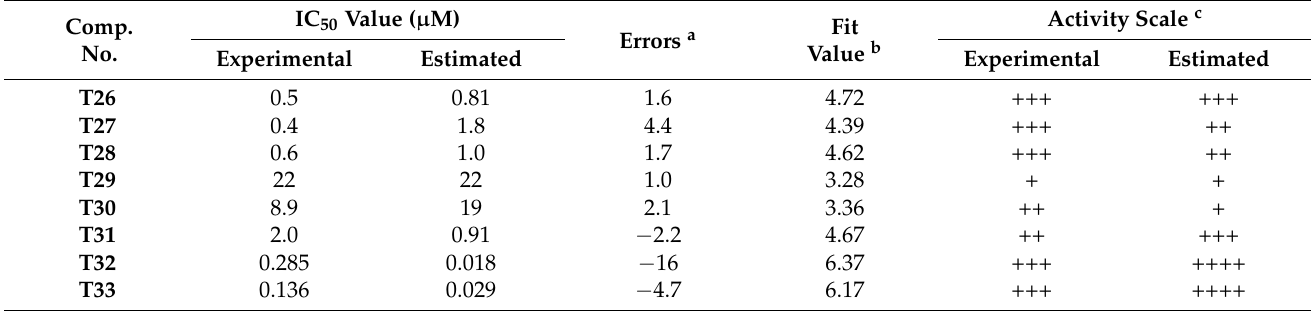
Table 3. Experimental and estimated activity of the test set compounds based on pharmacophore Hypo1.